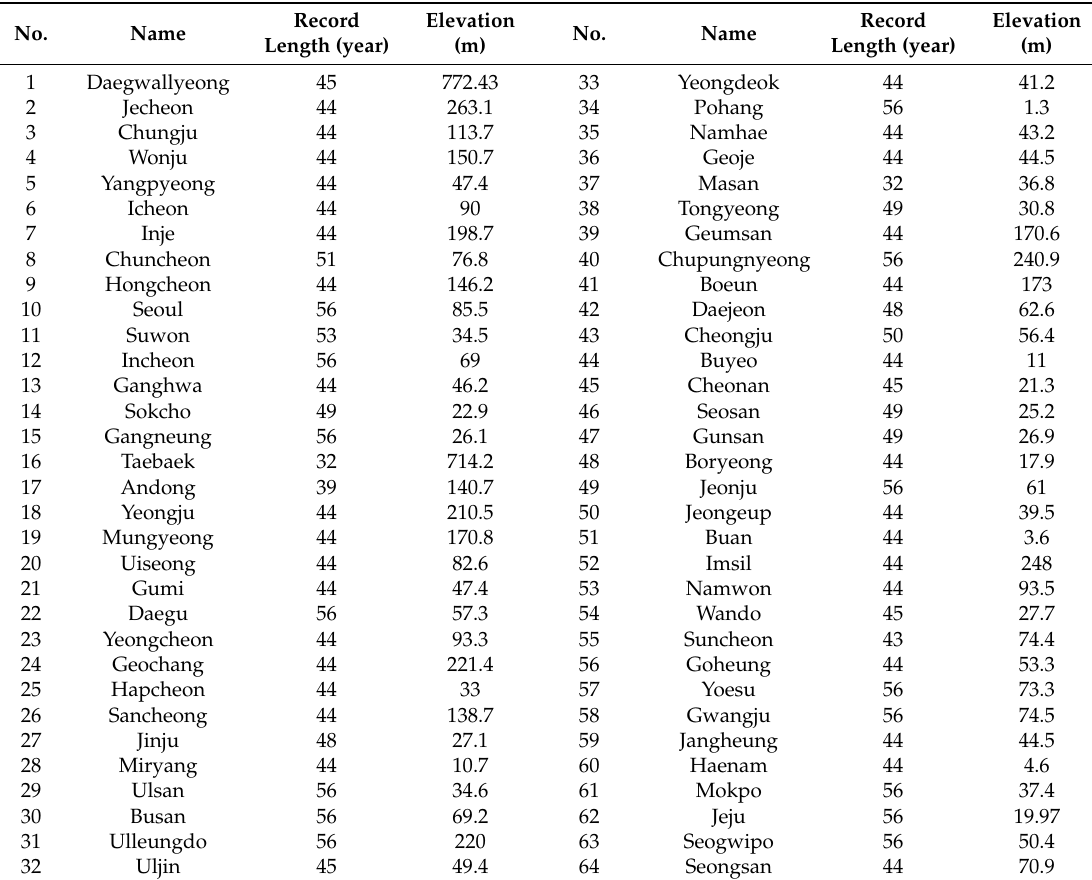
Table 1. The information of the KMA sites used in this